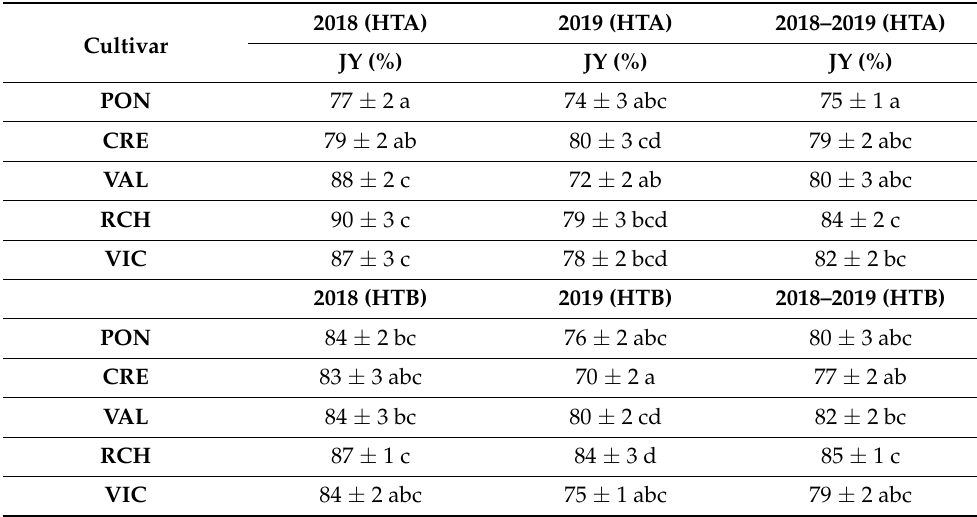
Table 6. Influence of cultivar and term of harvest on juice yield of rhubarb petioles.